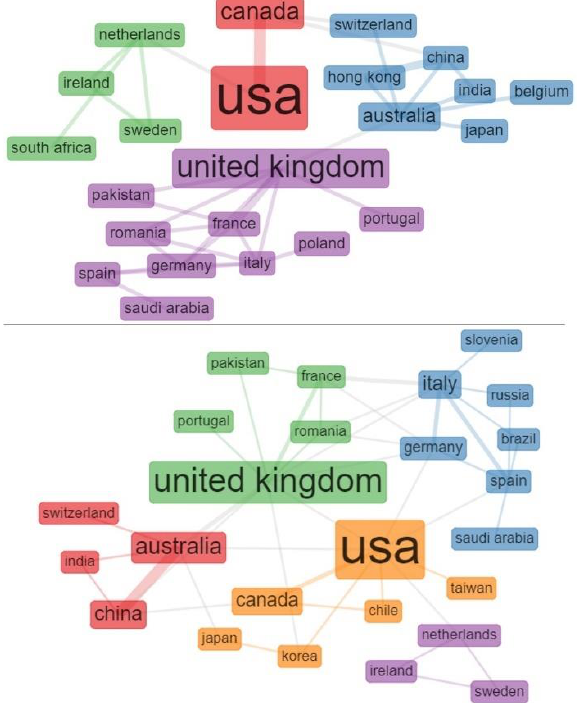
Figure 5. Collaboration Network, by Countries (Scopus at the top and WoS at the